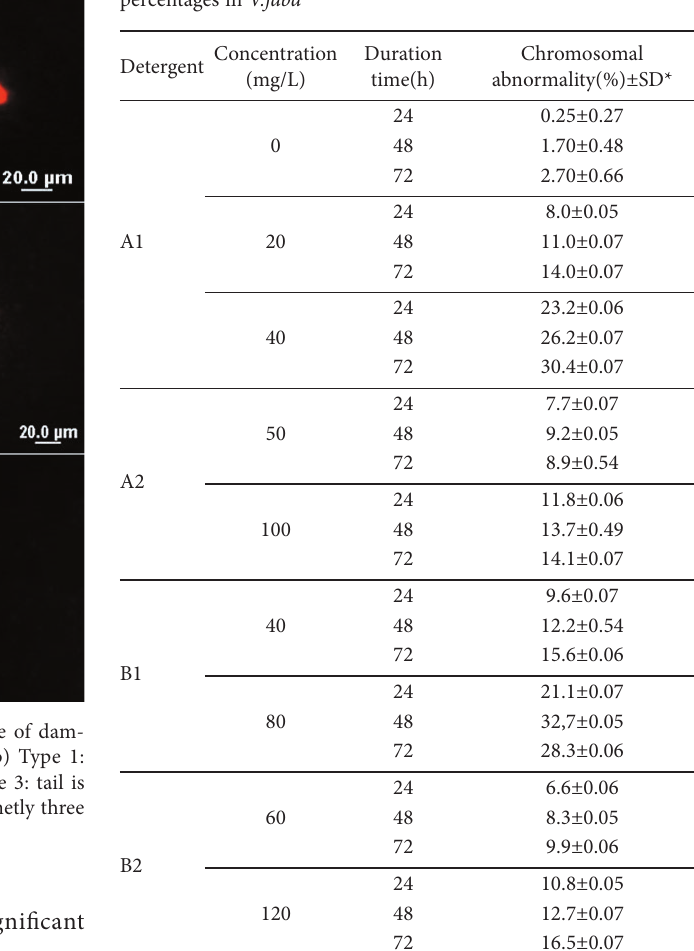
Table 4. Th e eff ect of the detergents on chromosomal